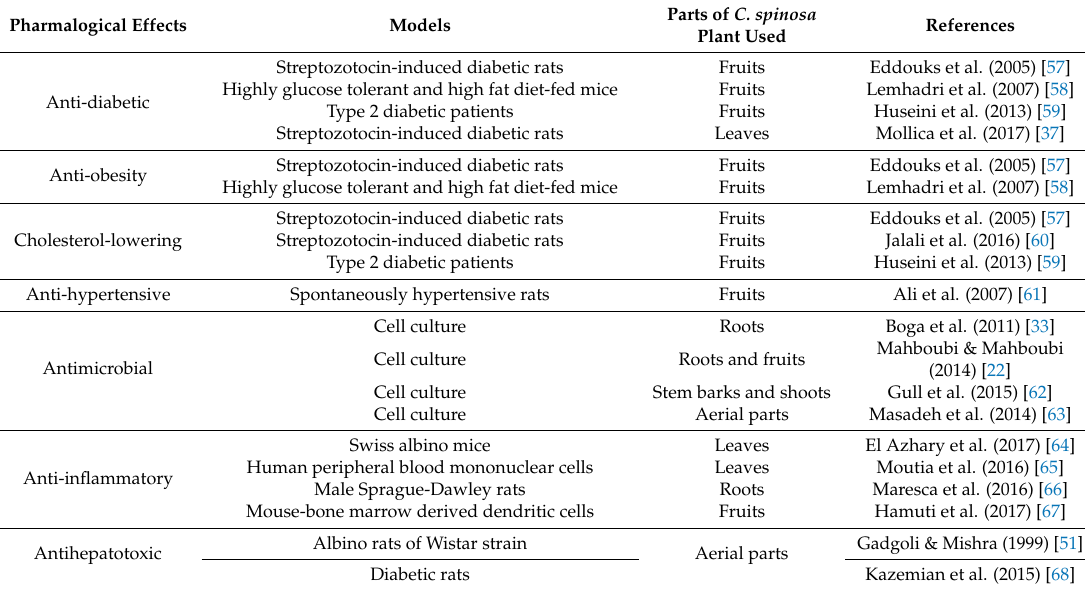
Table 3. Overview on major pharmacological effects of C. Spinosa